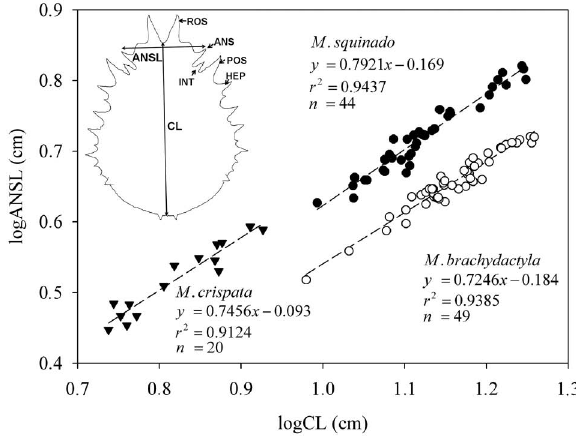
Fig . 1. – Relationship between carapace length (CL) and the dis- tance between the tip of the antorbital spines (ANSL) in Maja brachydactyla , M. squinado and M. crispata . ANS, antorbital spine; INT, intercalated spine; HEP, hepatic spine; POS, postorbital spine; ROS, rostral spine.